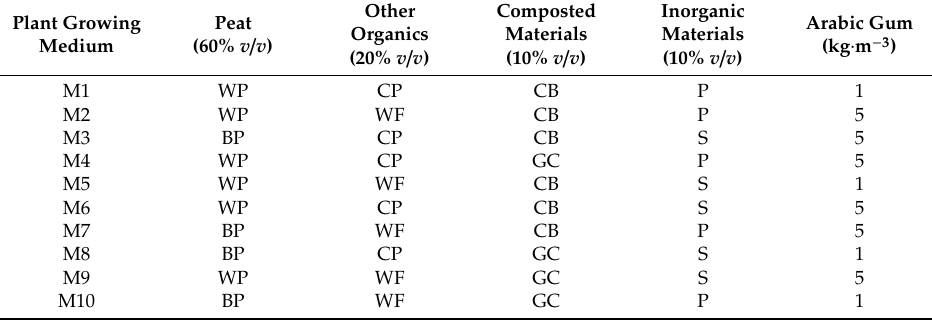
Table 2. Composition of Plant Growing Media. Each plant growing medium consists of 4 raw